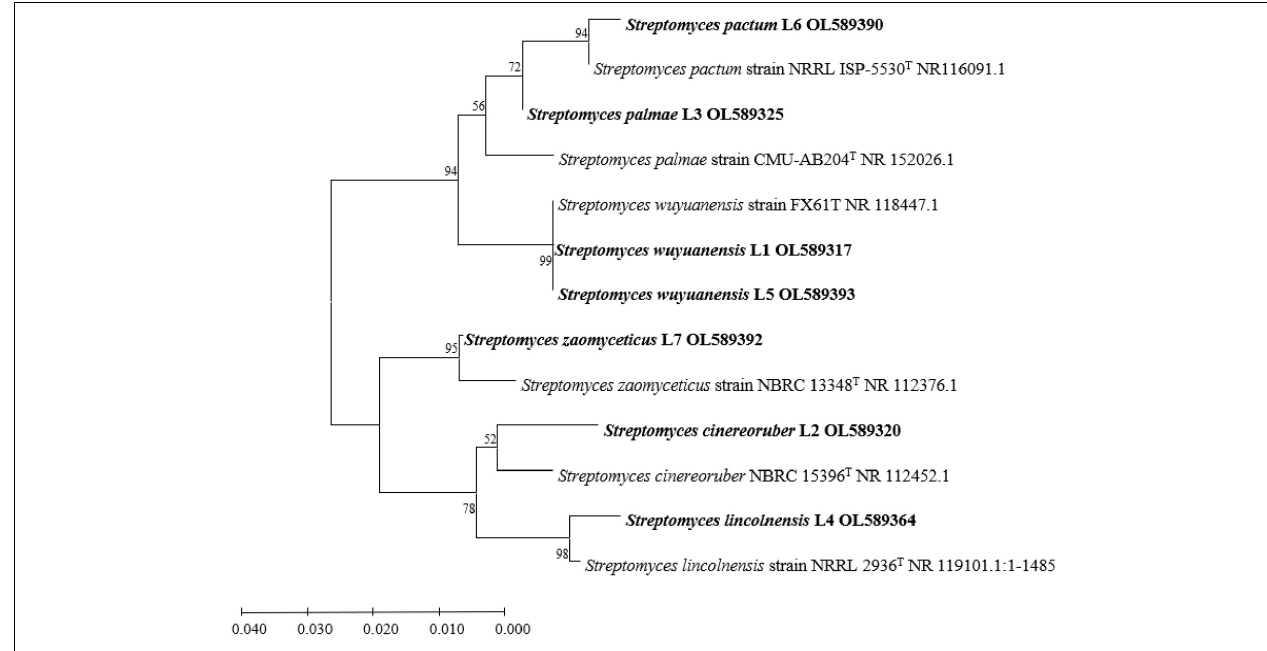
FIGURE 1 | Phylogenetics tree based on16S rRNA gene sequence of isolates L1–L7 and Streptomyces type strains.